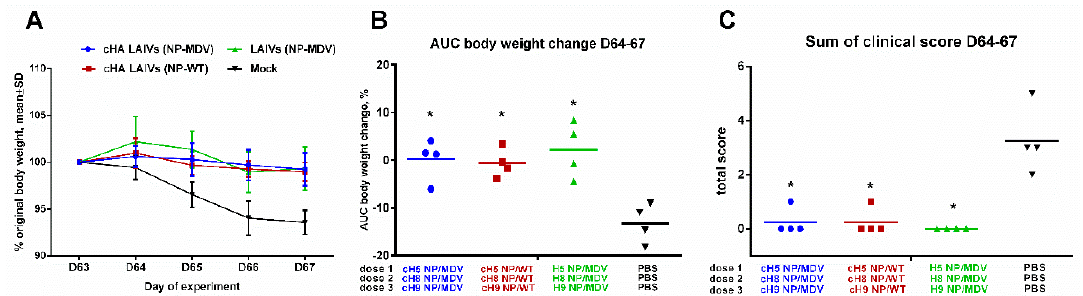
Figure 9. Clinical signs of influenza infection in immunized ferrets after challenge. ( A ) Dynamics of body weight change during the challenge phase. ( B ) Area under the curve of percentage body weight change for each ferret. ( C ) Sum of scores for clinical signs for each ferret during the four days after the challenge. * Significant difference from the mock-vaccinated group (Mann-Whitney U test).